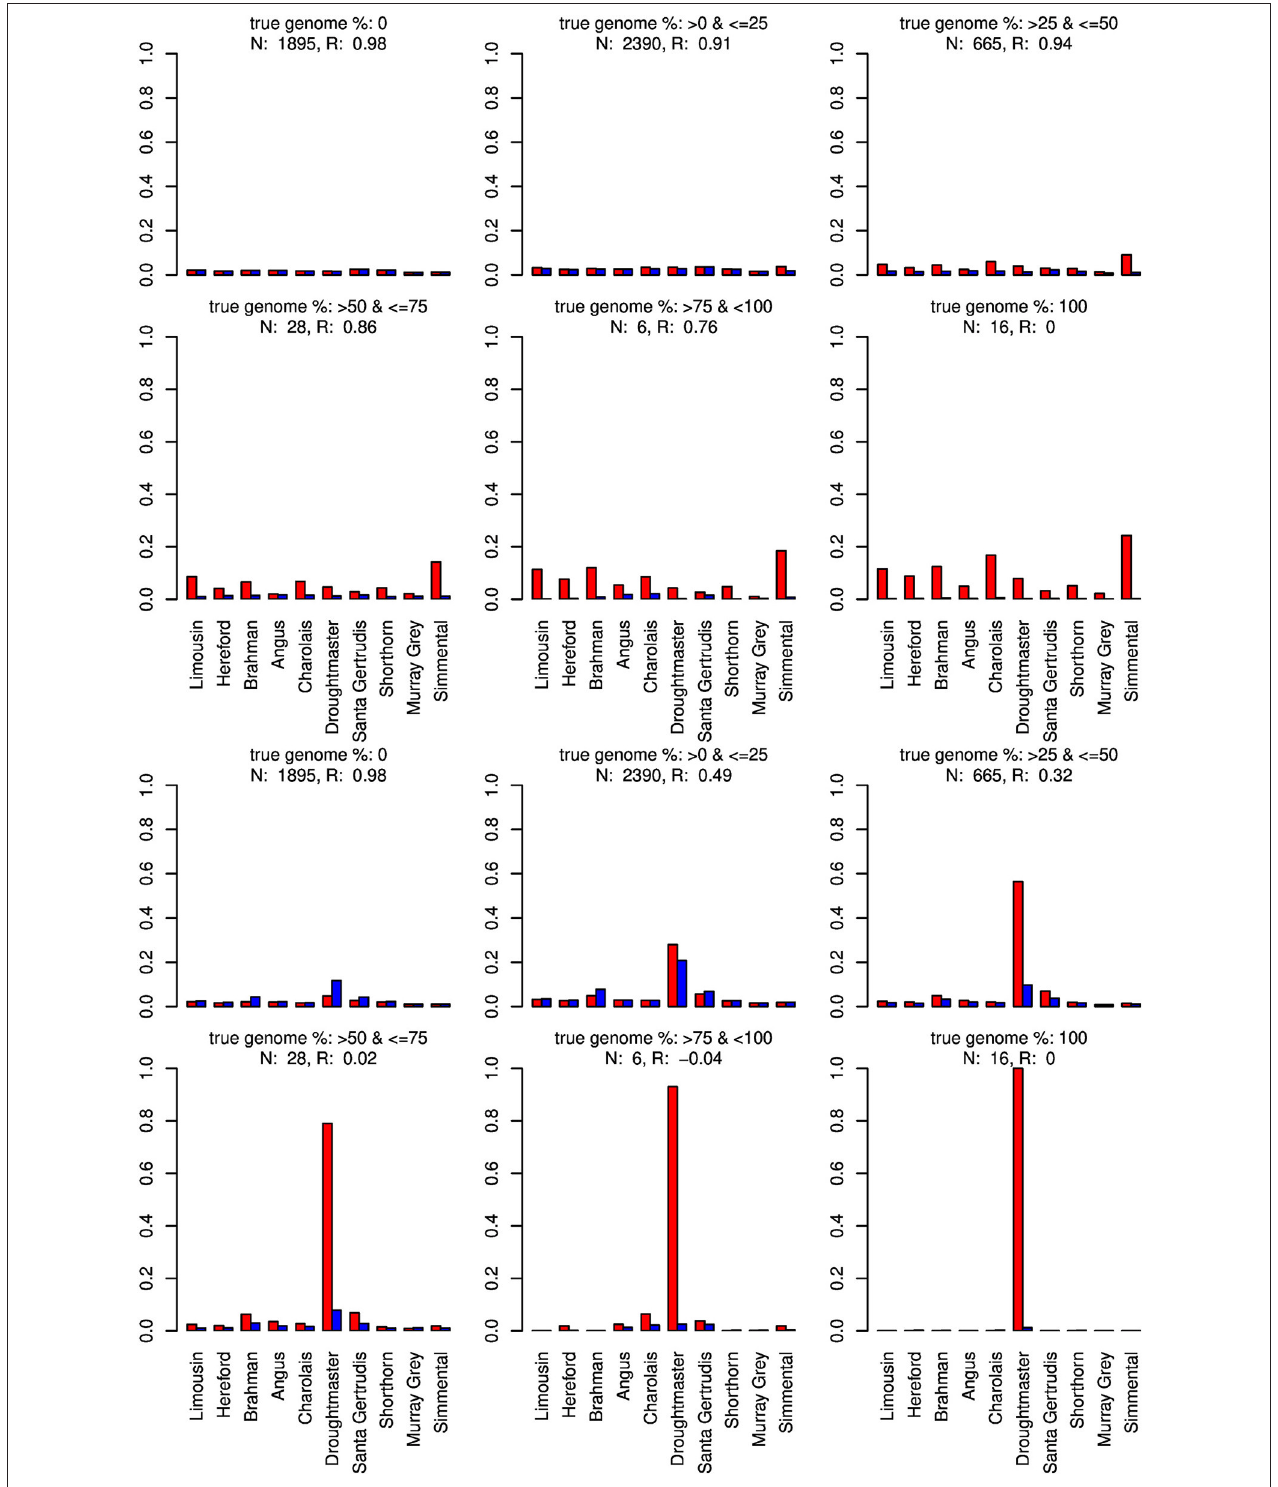
FIGURE 6 | Distribution of the average absolute estimation error within possible founder breeds for the 25 cross-over cattle data set from a model using all 11 breeds (blue) and a model excluding the Wagyu breed (red). Results are shown for categories of artificially admixed animals having 0%, > 0%– ≤ 25%, > 25%– ≤ 50%, > 50%– ≤ 75%, > 75%– < 100%, and 100% genome of the excluded breed. The graphs in the upper two rows show the results from CGR the lower two rows those from ADMIXTURE. R, correlation between the true and the estimated genome proportion when the Wagyu breed was excluded; N, number of used admixed individuals for calculating